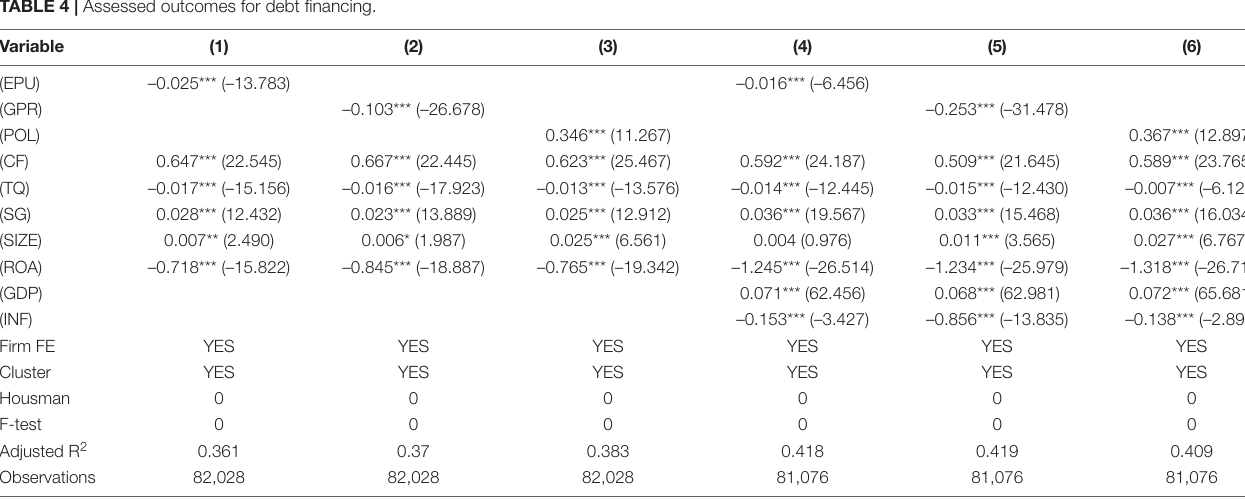
TABLE 4 | Assessed outcomes for debt